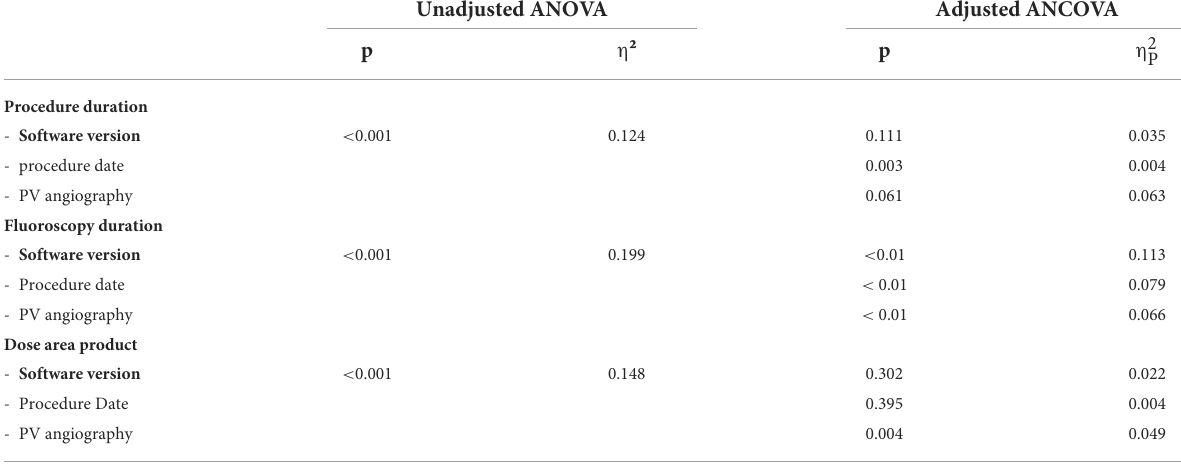
TABLE 2 Results of analysis-of-variance (ANOVA) testing and ANCOVA adjusting for procedure date and PV angiography. Unadjusted